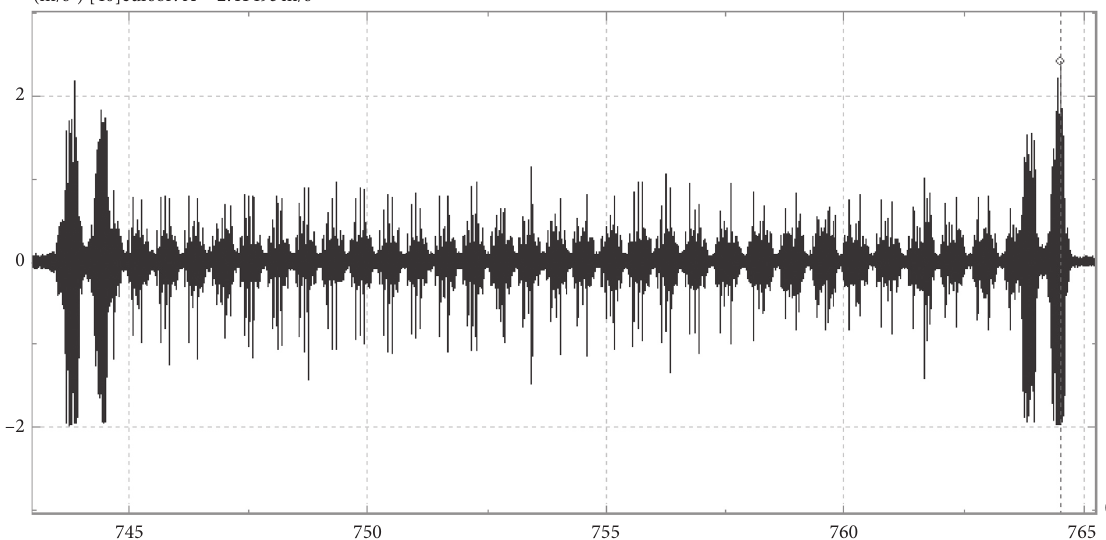
Figure 17: Time domain characteristic diagram of vibration acceleration along the vibration direction ( Z -axis) in the intact zone. (m/s 2 ) [49]cursor: A = 3.98592m/s 2